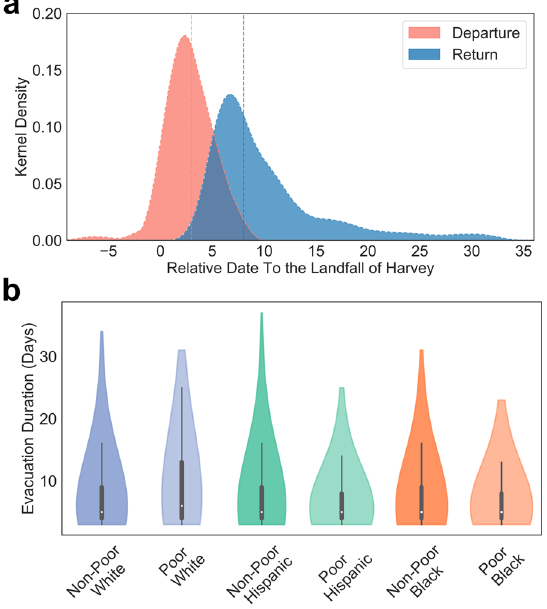
Fig. 2 Evacuation distance and destination choice. a The distribution of evacuation distance for residents from different block group categories.